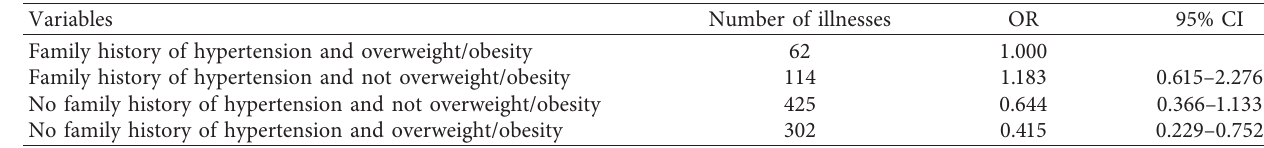
Table 5: The influence of family history of hypertension and overweight/obesity on